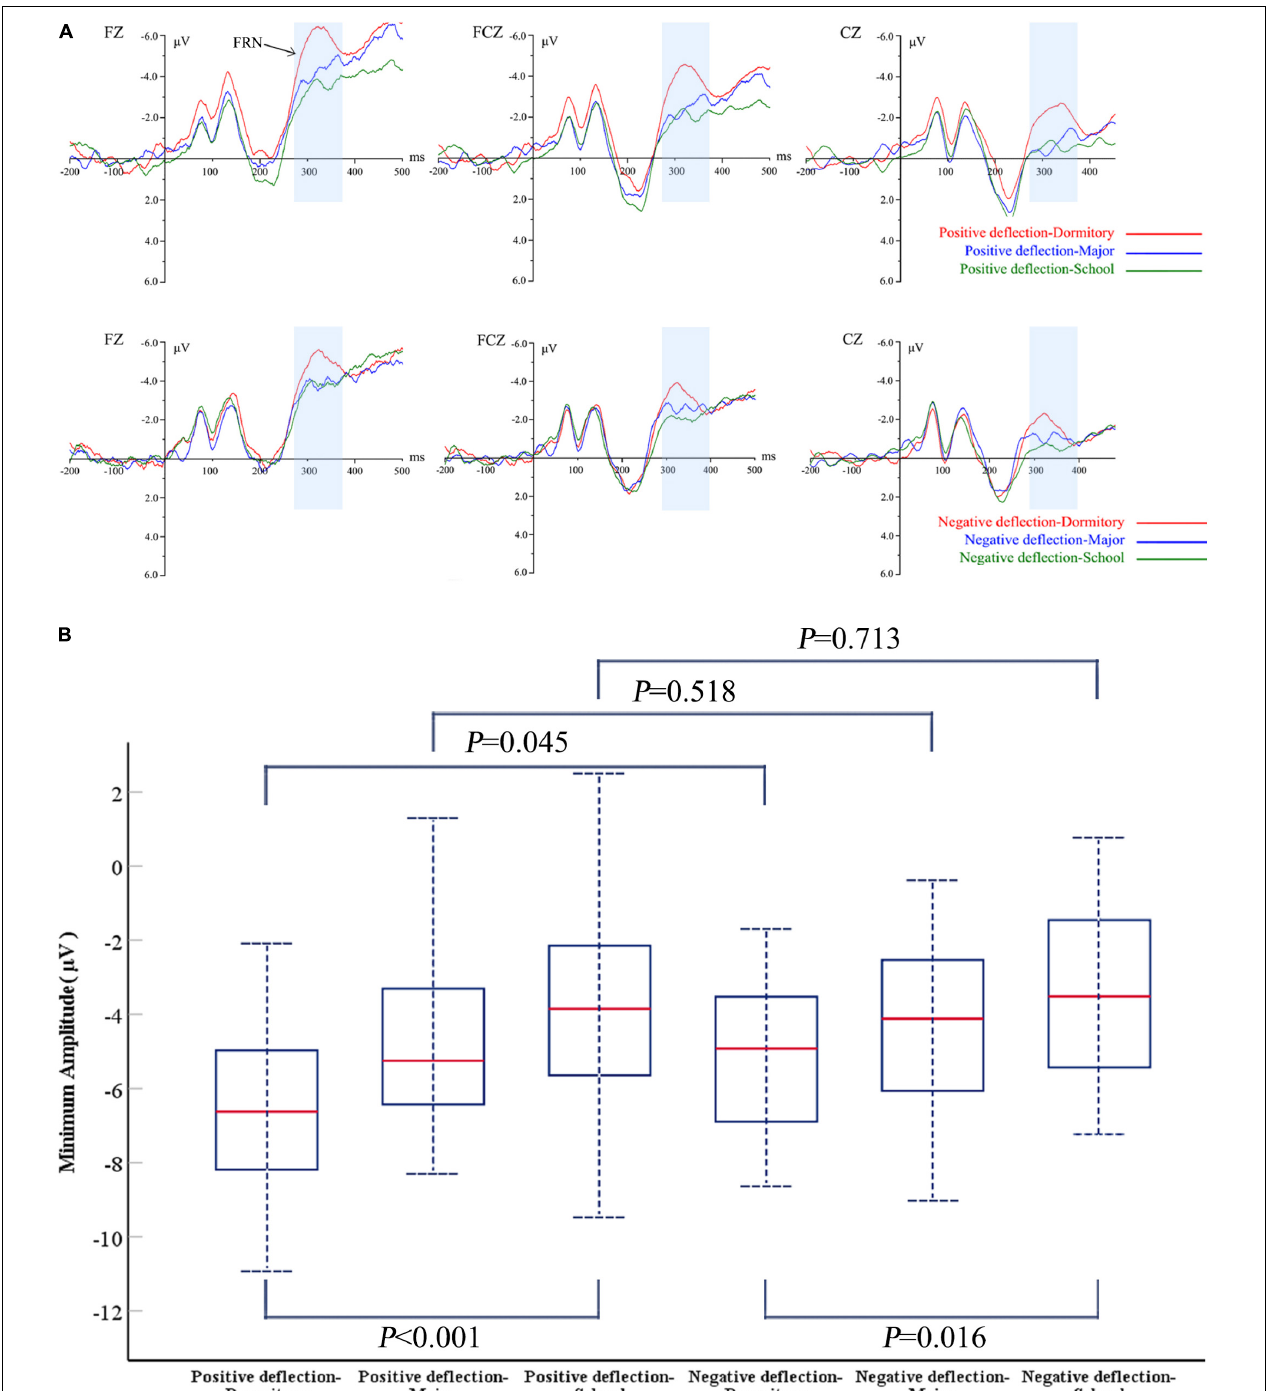
FIGURE 3 | (A) Grand averaged ERPs waveforms at FZ, FCZ, and CZ of social norm deviations from different social distances in Task 1. (B) ANOVA results of social norm deviations from different social distances in Task 1.